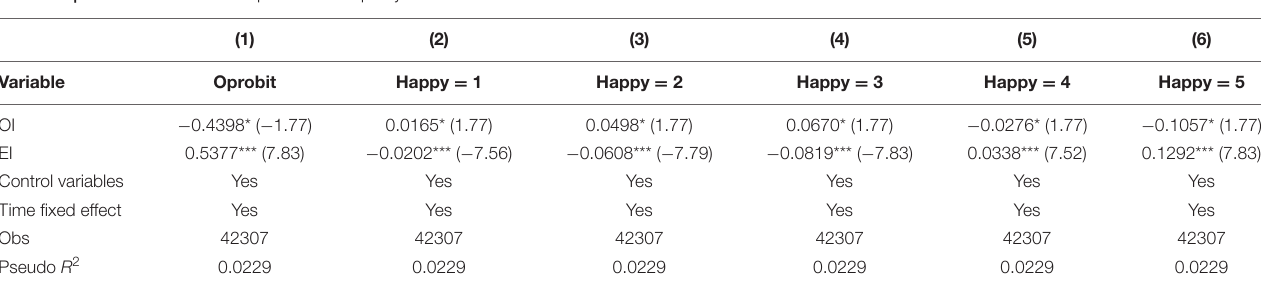
TABLE 8 | Robustness tests: Use provincial inequality